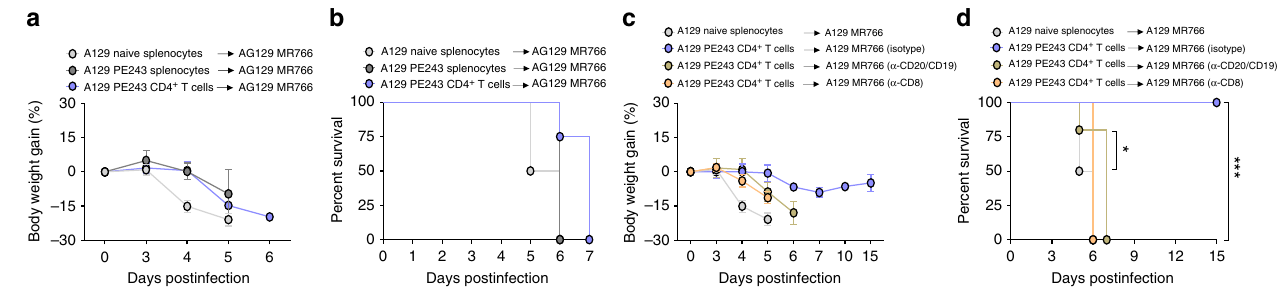
Fig. 5 IFN γ , CD8 + T and B cell are crucial in CD4 + T cell protection against ZIKV MR766. Recipient AG129 mice or A129 mice depleted of B cell or CD8 + T cells were inoculated intravenously with 2 × 10 5 PFU of lethal ZIKV MR766. Simultaneously, the animals received immune splenocytes (5 × 10 7 /mouse) or immune CD4 + T cells (5 × 10 7 /mouse) obtained from ZIKV PE243-infected A129 donor mice at 7 days postinfection. Uninfected mice were used as donor of naive splenocytes to MR766-infected A129 control mice ( n = 8). a Body weight gain and b lethality of recipient AG129 mice that received immune splenocytes ( n = 6) or immune CD4 + T cells ( n = 4) monitored for up to 7 days postinfection. c Body weight gain and d lethality of recipient A129 mice depleted of B cells ( n = 5) or CD8 + T cells ( n = 4) that received immune CD4 + T cells monitored for up to 15 days. IgG2a isotype control were used to exclude non-speci fi c effects of B cell depleting antibodies ( n = 8). Results are shown as mean ± standard deviation in a and c . Data are presented as a pool